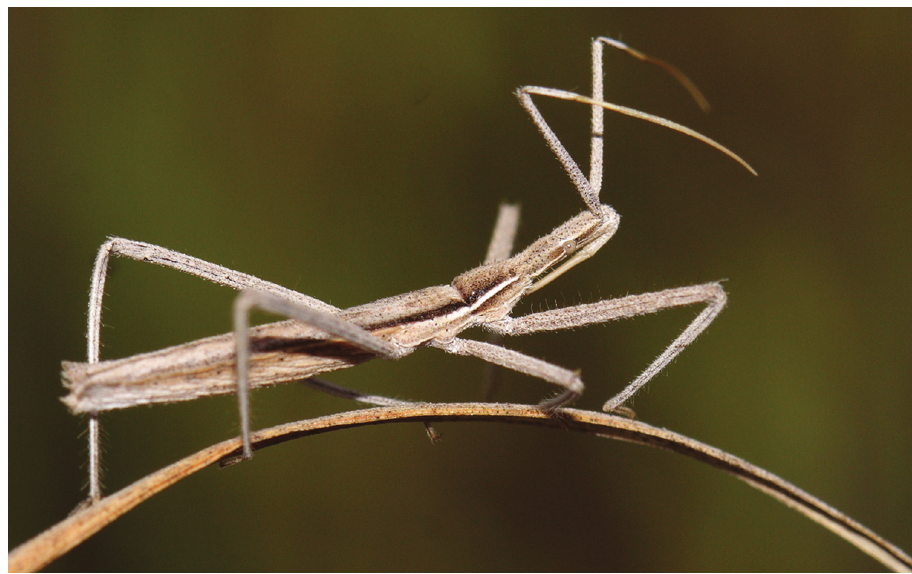
Figure 4. Vibertiola cinerea Horváth, 1909 (Reduviidae, Harpactorinae). Photo JM Sesma. Determina- tion L.